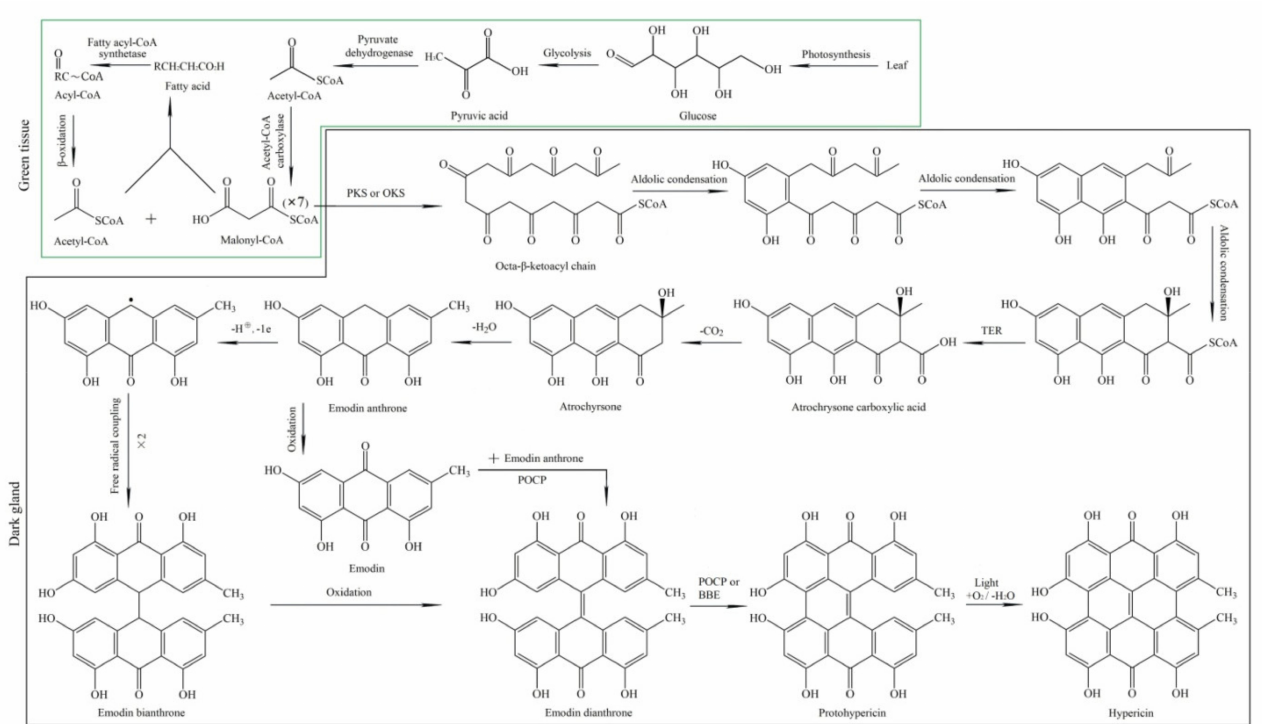
Figure 1. Pathway of Hyp biosynthesis from glucose to acetyl- and malonyl-coenzyme A (CoA) in the cells of green tissues (green frame) and from acetyl- and malonyl-CoA to Hyp in the cells of dark glands (black frame). PKS, polyketide synthase; OKS, octaketide synthase; TER, thioesterase; POCP, phenoloxidative coupling protein and BBE, berberine bridge